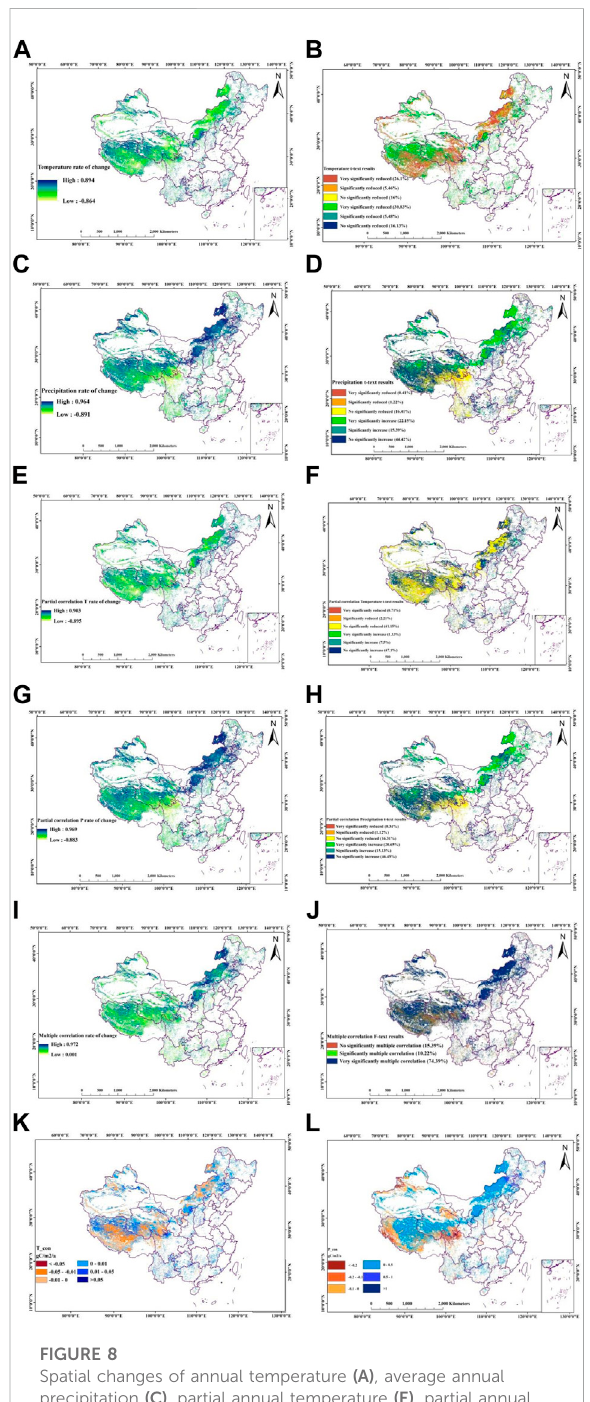
FIGURE 8 Spatial changes of annual temperature (A) , average annual precipitation (C) , partial annual temperature (E) , partial annual precipitation (G) , and multiple correlation (I) and Spatial variation trends in annual temperature (B) , annual mean precipitation (D) , partial annual temperature (F) , partial annual precipitation (H) , multiple correlation (J) of grasslands in China during 2001 – 2019. Spatial distributions of the contributions of (K) temperature (T_ con) and (L) precipitation (P_con) to grassland NPP